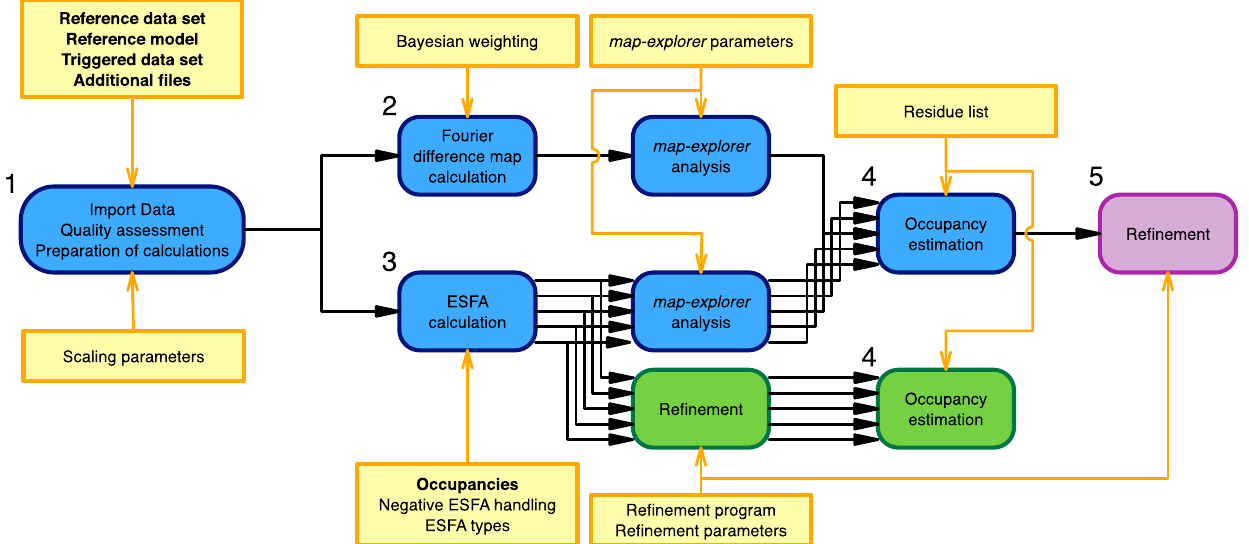
Fig. 1 Design of Xtrapol8. Xtrapol8 roadmap. The four main steps followed by Xtrapol8 are depicted in blue. User input are highlighted by yellow boxes, with obligatory input further highlighted in bold. Steps speci fi c to the ‘ fast-and-furious ’ (default options: q -weighting of difference map and ESFAs, rescue of negative ESFAs using the truncate method, occupancy determination based on the difference-map method; additional step 5: re fi nement in both reciprocal- space and real-space at the automatically determined occupancy) and ‘ calm-and-curious ’ modes are boxed in purple and green, respectively.